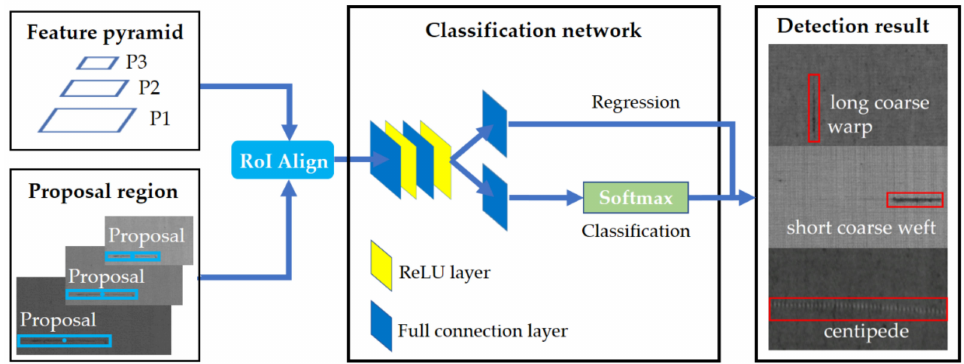
Figure 4. The architecture of the classification network in the PRAN-Net.